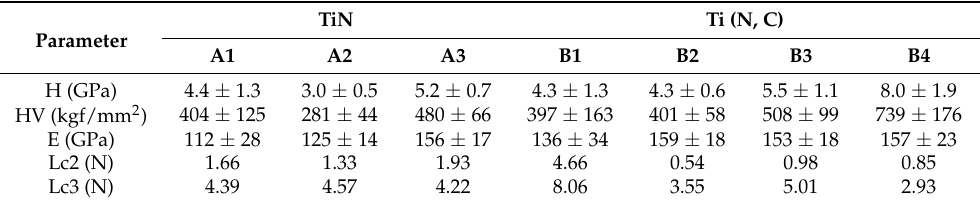
Table 2. Mechanical characteristics of coated samples. H—indentation hardness; HV—conversion to kgf/mm 2 from GPa; E—indentation elastic modulus; Lc2—second critical load; Lc3—third critical